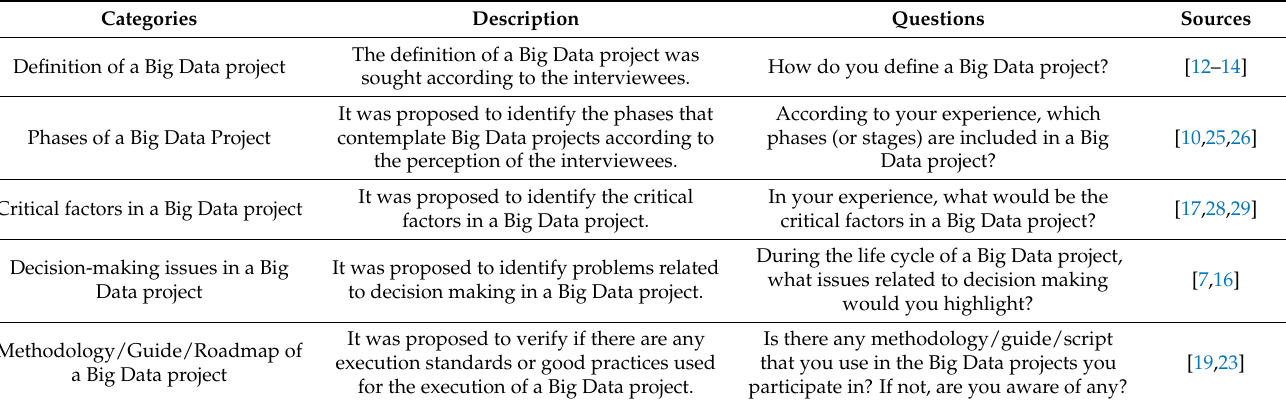
Table 1. Initial categories of